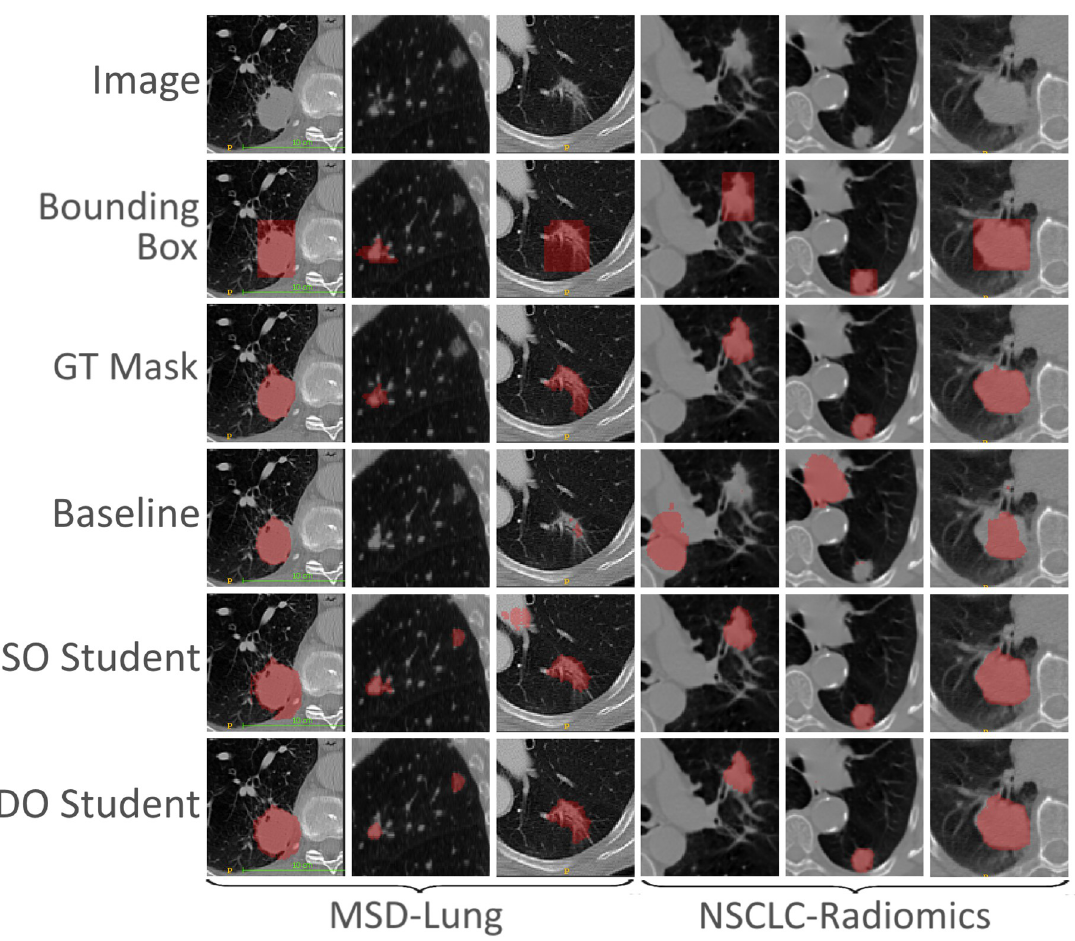
Fig 3. A sample of the results produced by the scarce students on the test set. The figure shows the input image, bounding box, and ground truth (GT) mask in the three top rows, respectively. The baseline model, single output (SO) Student, and dual output (DO) Students corresponding outputs are shown in the three bottom rows,